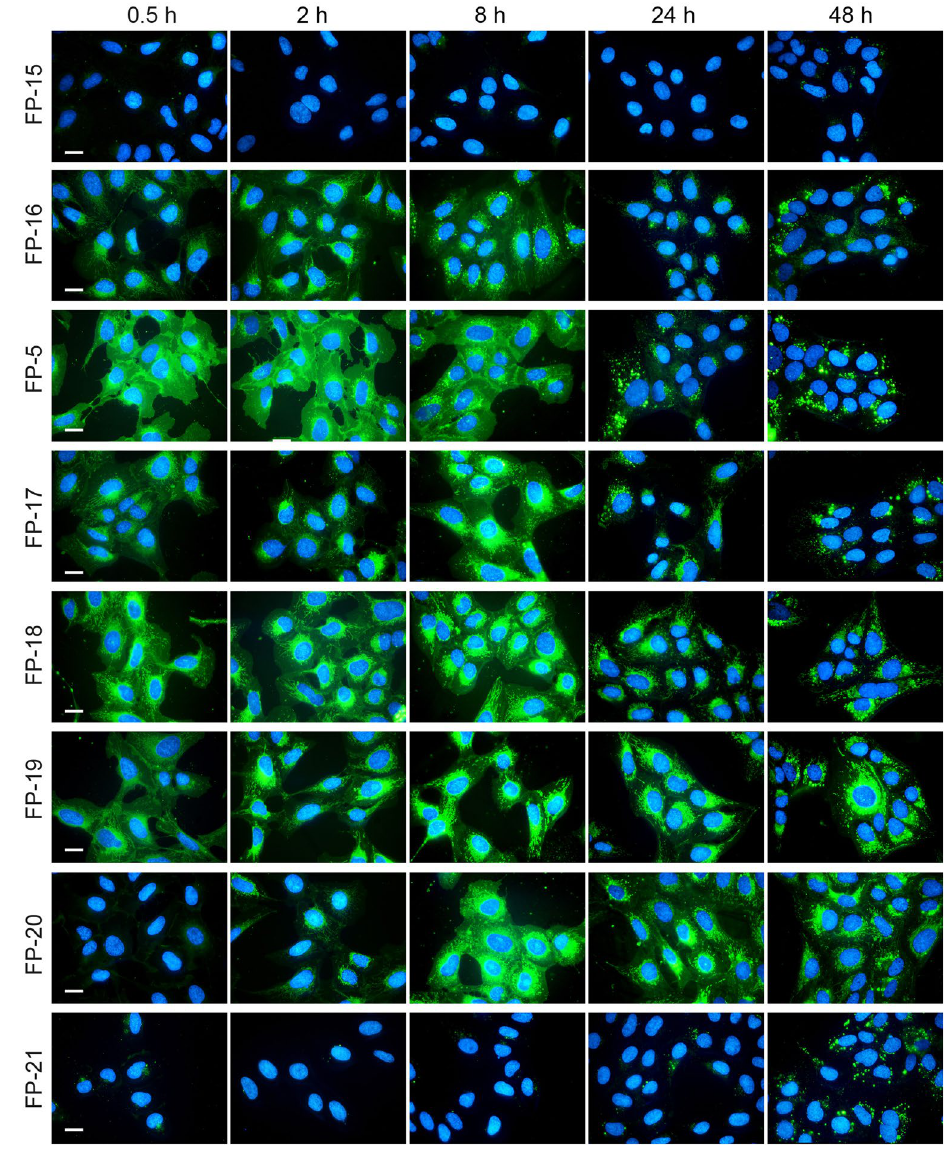
Figure 3. Uptake of FP-5 analogues by U-2 OS cells. FP-5 analogues at 200 nM concentration were added to the cultivation medium containing 5% LPDS and representative images of the localization of fluorescent probes in cells were taken at indicated times 0.5, 2, 8, 24, and 48 h. Nuclei labelled with Hoechst 33342 are shown in blue. Scale bar 10